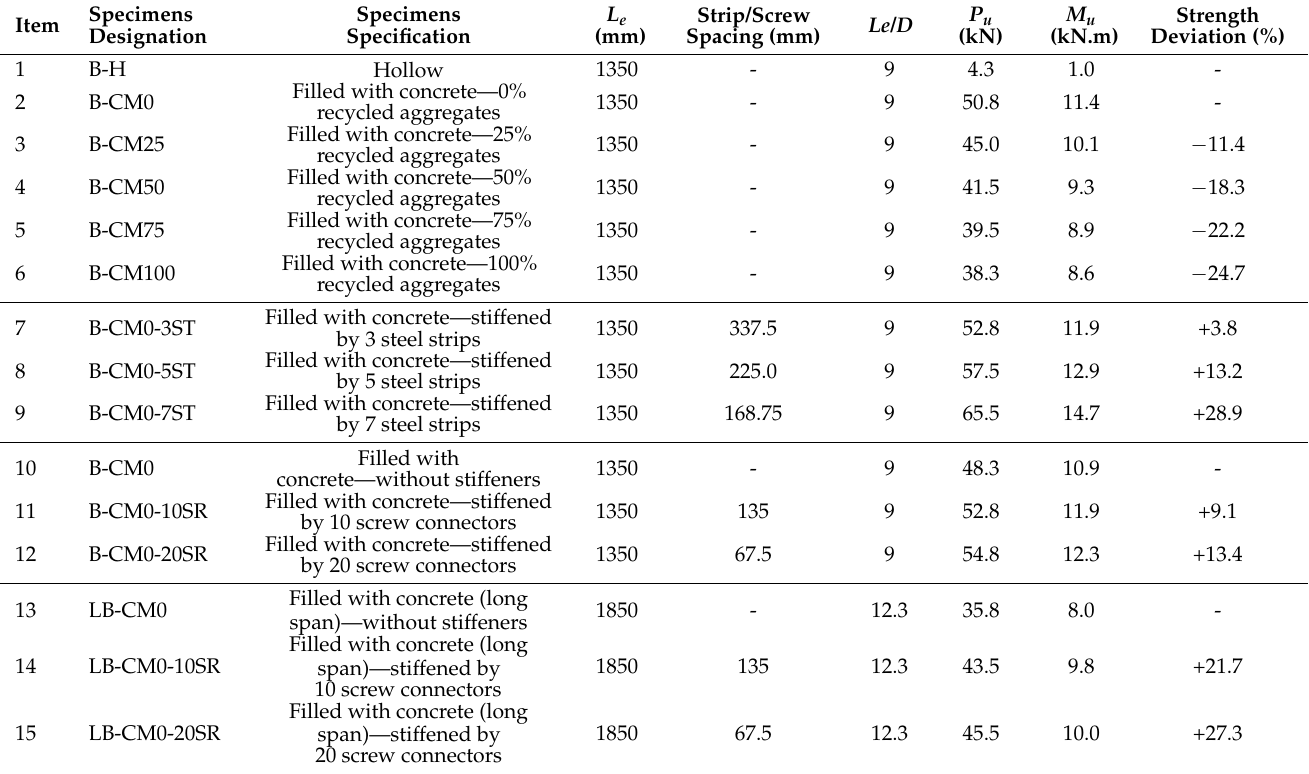
Figure 1. Sketch of suggested specimens with C-sections filled with concrete (out of scale). Table 1. Designations and results of the tested specimens.